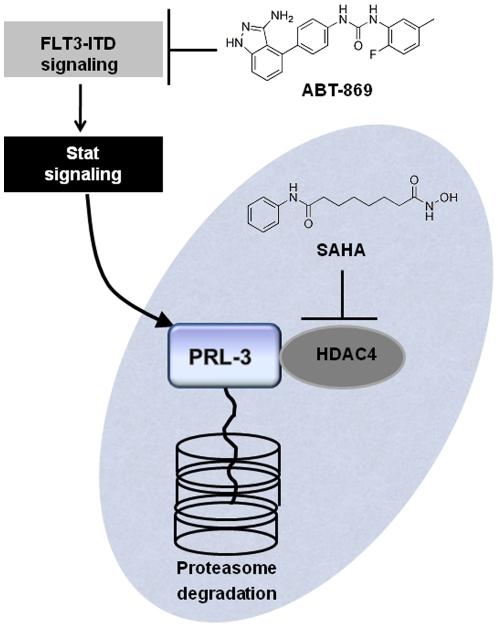
Schematic representation of the molecular mechanisms of enhanced downregulation of PRL-3 by combination treatment with ABT-869 and SAHA.ABT-868-induced inhibition of PRL-3 is due to targeting upstream FLT3-ITD and Stat pathway. HDAC4 physically interacts with PRL-3. SAHA mediated degradation of PRL-3 is dependent on the proteasome pathway.